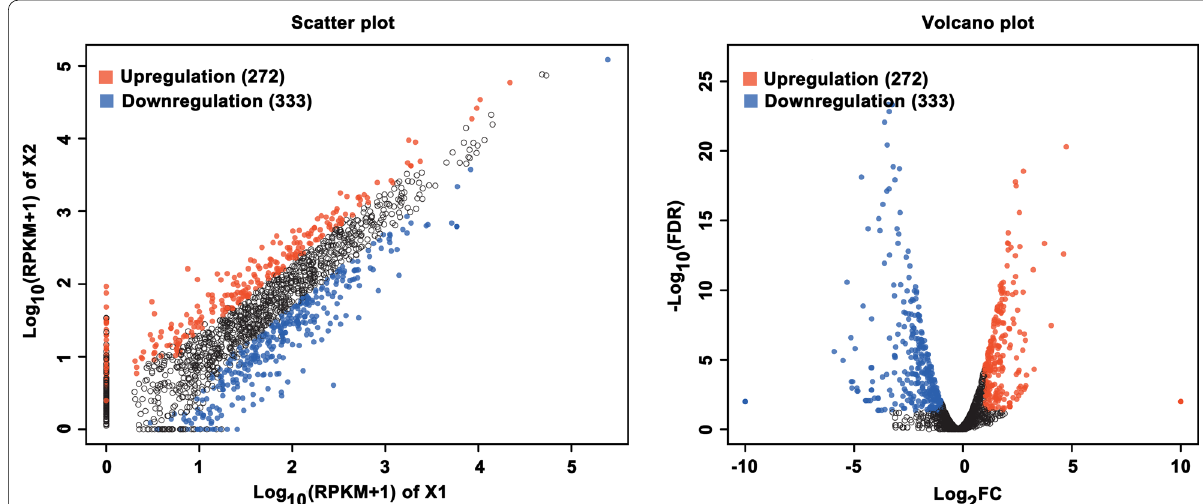
Fig. 4 Visualized distribution of the differentially expressed genes between X2 and X1 by scatter plot and volcano plot